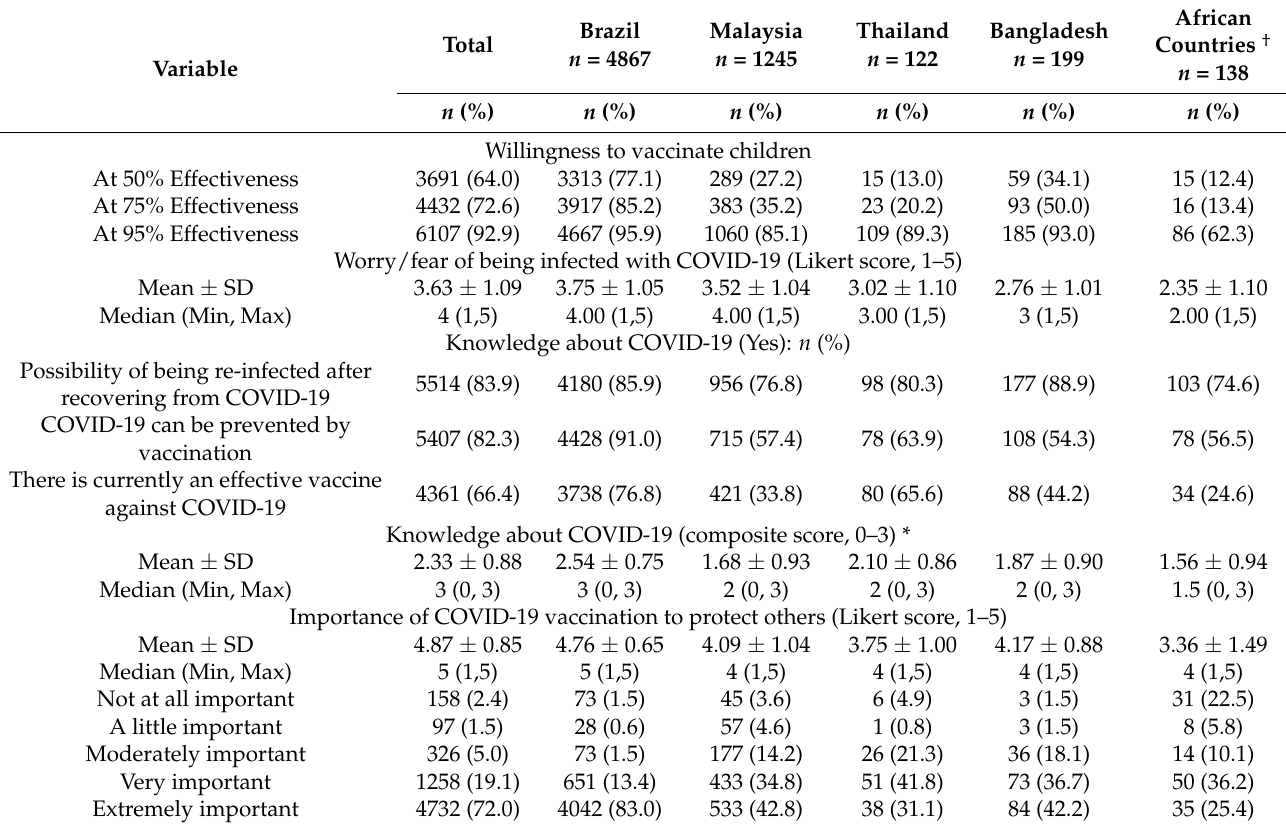
Table 2. Knowledge and attitudes towards COVID-19